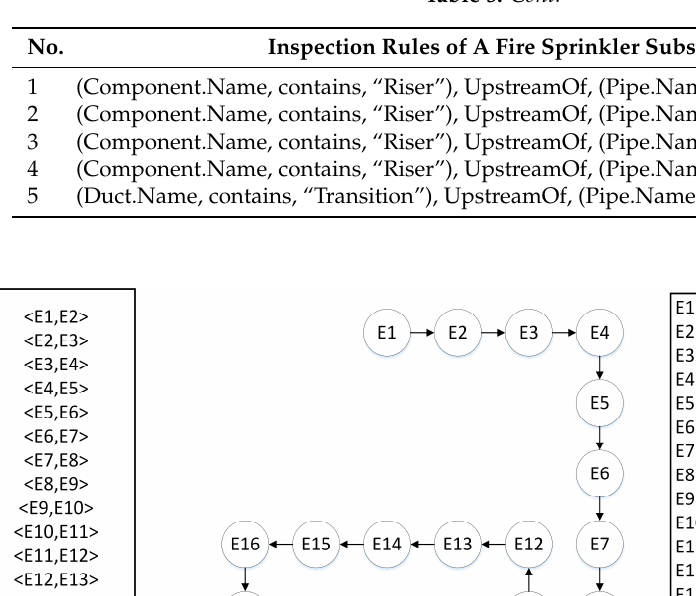
Table 5. Part of inspection rules of MEP subsystem.